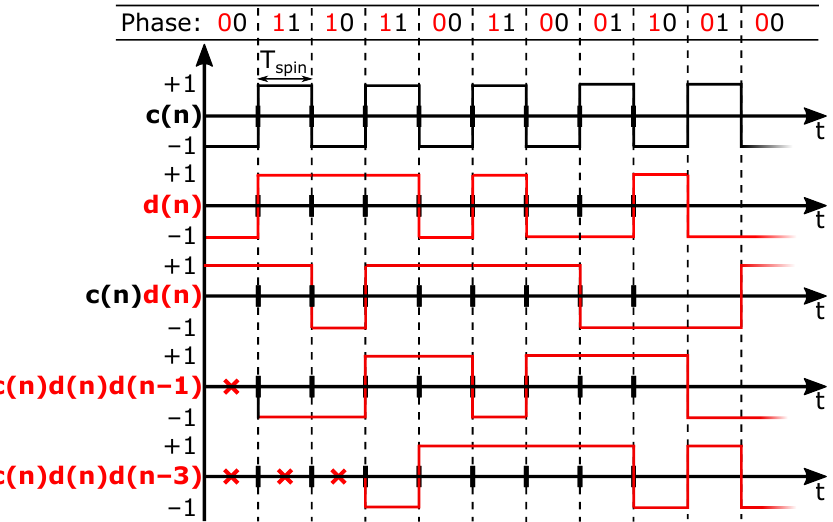
Figure 5. Example of modulation functions resulting from randomized four-phase